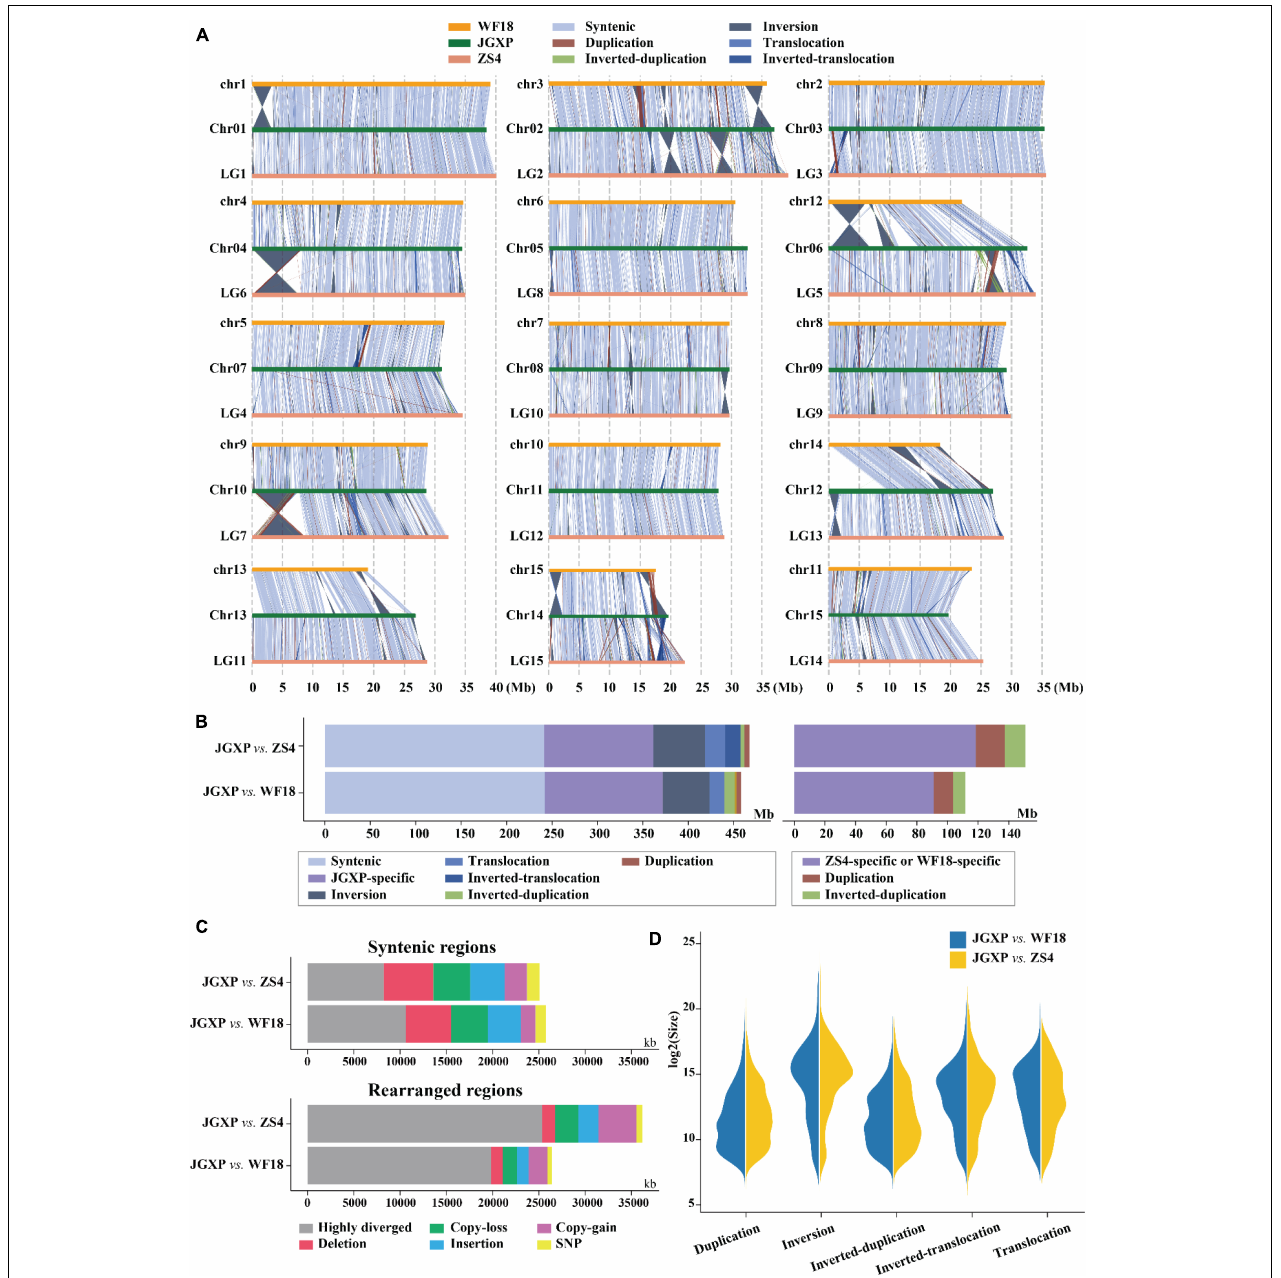
FIGURE 3 | Comparative analysis among the three yellowhorn assemblies of “JGXP,” “ZS4,” and “WF18.” (A) Structural variations between the reference “JGXP” and the other two cultivars of yellowhorn genomes. The chromosome in the query genome has been reverse complemented if the majority of alignments between homologous chromosomes were inverted. (B) Barplot showing the total length of structural variations. (C) Barplot showing the sequence differences in the structural variations of syntenic (upper) and rearranged (lower) regions for “JGXP vs. ZS4” and “JGXP vs. WF18.” (D) Size distributions of different types of structural